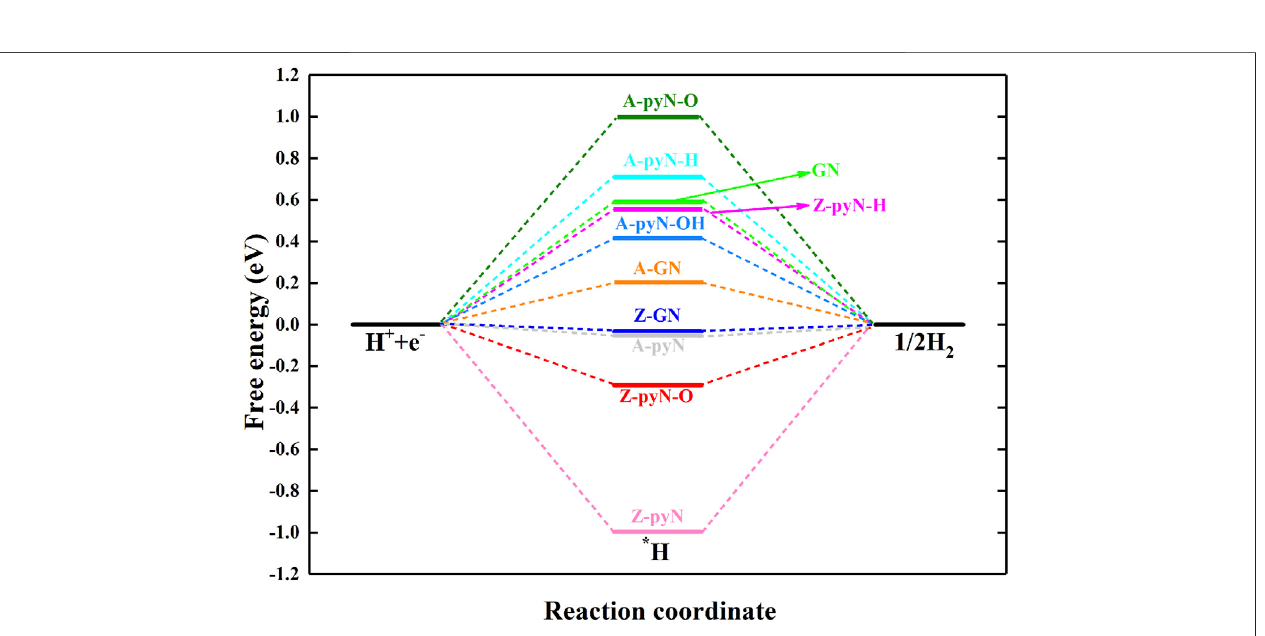
Frontiers in Chemistry |